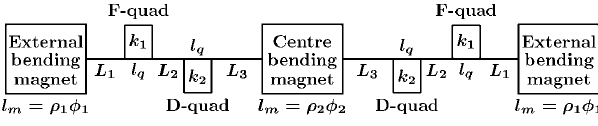
FIG. 1. An isochronous insertion consisting of three bending